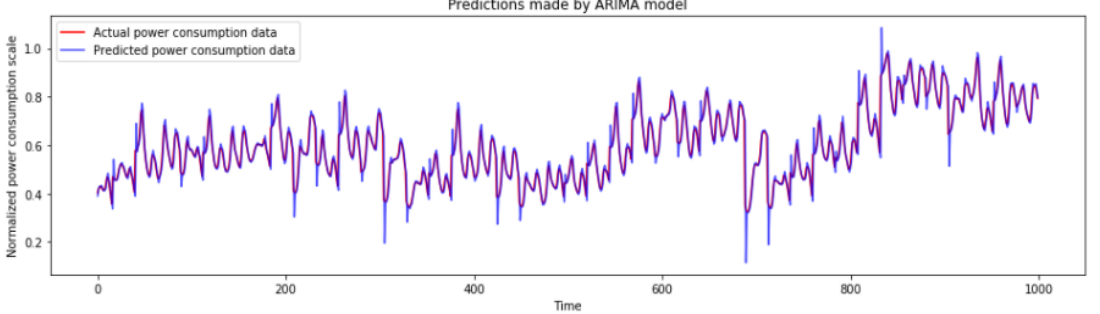
Figure 5. Flowchart of power theft detection procedure.